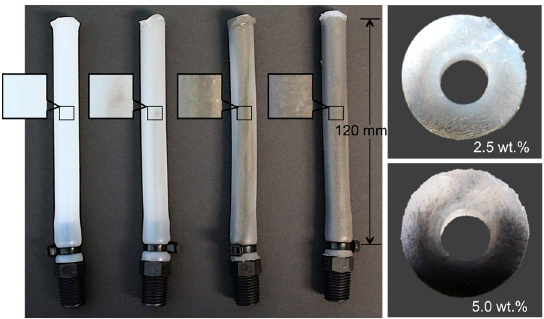
Figure 2. Bilayer composite soft bending actuators with different concentrations of nickel particles: 0, 0.5, 2.5, and 5.0 wt % (from left to right). The increased nickel particle concentrations are shown with color changes.